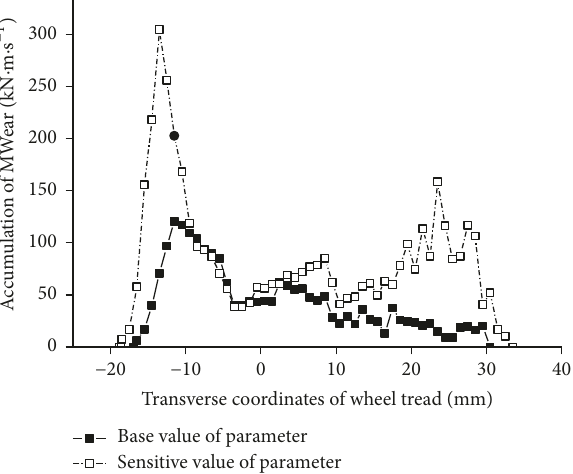
Figure 4: Influence of track parameters on the maximum wear power dissipation. Figure 5: Influence of the coefficient of damping of antihunting